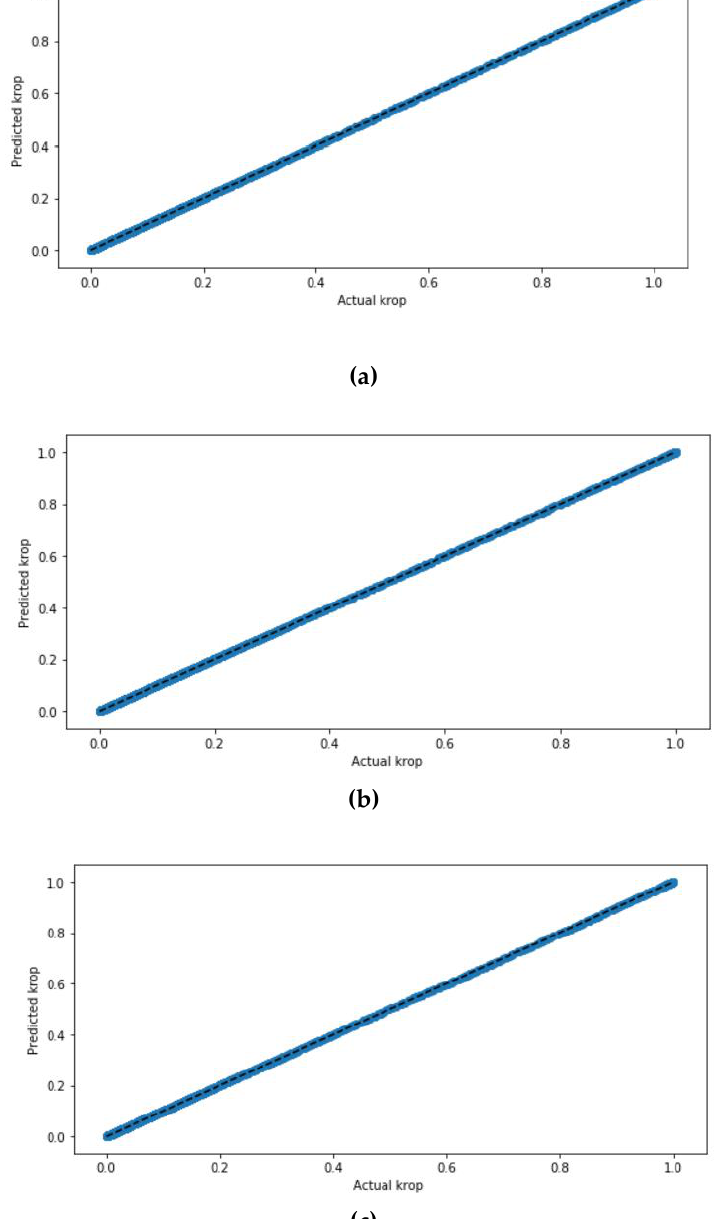
Figure 11. ANN prediction with different activation functions (a) “ReLu” activation function, (b) “sigmoid” activation function, and (c) “tan h ” activation function, for the target k rop . The dashed line represents a full coinciding between actual and predicted data.